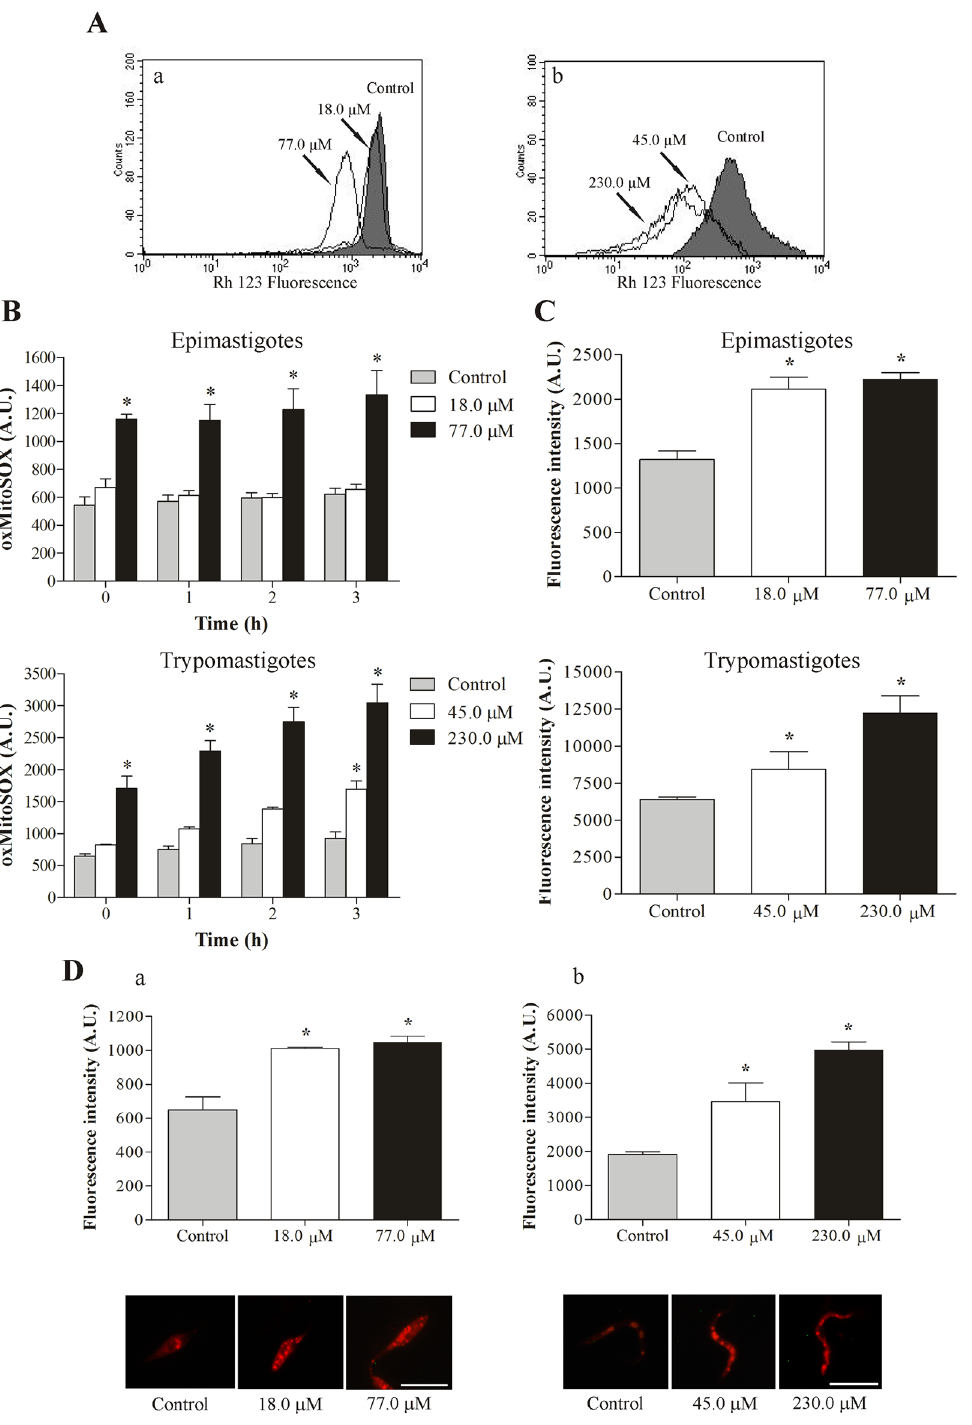
Fig 2. Evaluation of mitochondrial membrane potential, ROS production and lipid inclusions in T . cruzi treated with C4. (A) Mitochondrial depolarization in T . cruzi treated with C4 for 3 h and stained with the fluorescence probe Rh 123. (a) Epimastigote forms. (b) Trypomastigote forms. Arrows correspond to the concentrations tested. The control group (untreated parasites) is also shown. (B) Mitochondrial O 2 (cid:129) − production in epimastigote and trypomastigote forms of T . cruzi treated with C4 for up to 3 h. Mitochondrial O 2 (cid:129) − production was evaluated using the fluorescence probe MitoSOX. At the indicated times, oxidized MitoSOX (oxMitoSOX) was fluorimetrically measured in the parasites. (C) Total ROS production in epimastigote and trypomastigote forms of T . cruzi treaded with C4 for 24 h and stained with the cell-permeable probe H 2 DCFDA. (D) Lipid inclusions in T . cruzi treated with C4 for 24 h and